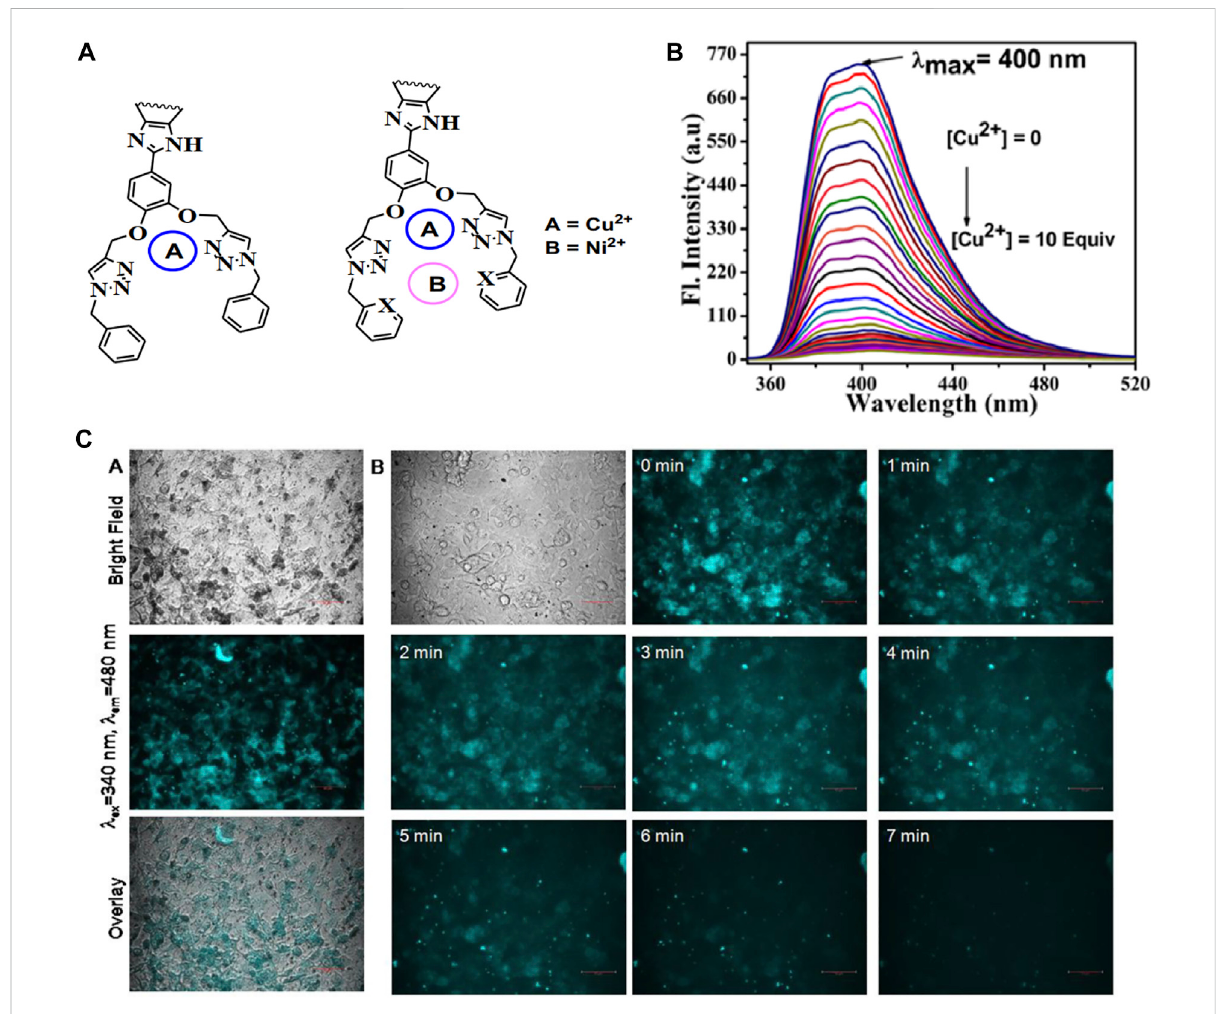
FIGURE 6 (A) Dual-cavities and probable binding mode of the sensors; (B) emission spectra of probe P3 with the incremental amount of Cu 2+ in ACN; (C) fl uorescentbio-imagesofC6(ratglialcell)incubatedwithP3andcellincubatedwithP3alongwithCu 2+